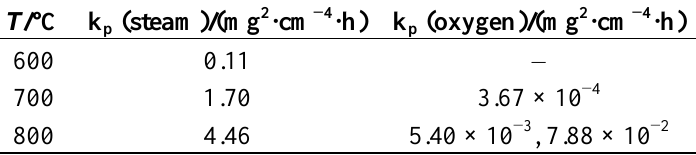
Table 1. Summary of parabolic rate constants.